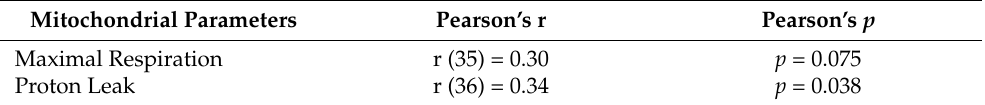
Table 1. Correlation between plasma levels of NGF and mitochondrial